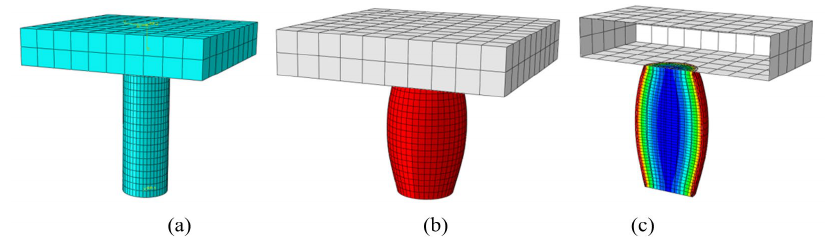
Figure 16. Schematization: (a) numerical model, (b) corresponding axial deformation, and (c) temperature